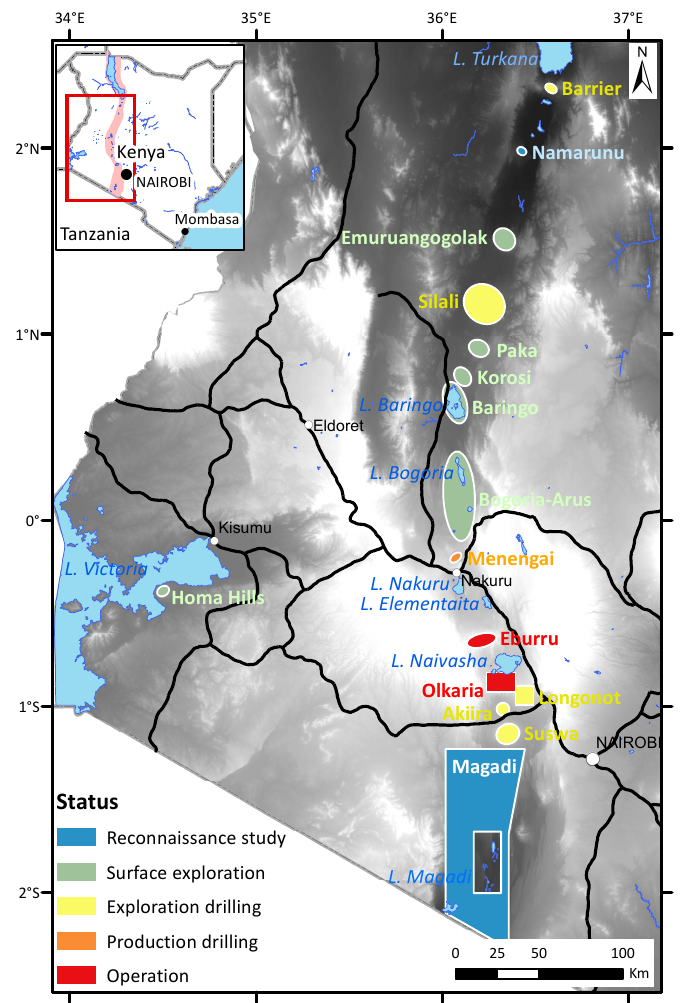
Figure 2. Map of the Kenyan Great Rift Valley showing the location of the main geothermal fields and their status as of 2018 (redrawn after [19]). The concession extent is only known for Olkaria [20], Longonot [1] and Magadi [21] fields. All the prospects (except Homa Hills) are located in an area of lower elevations (darker shades of grey) that represents the eastern branch of the East African Rift System (EARS, pink area in